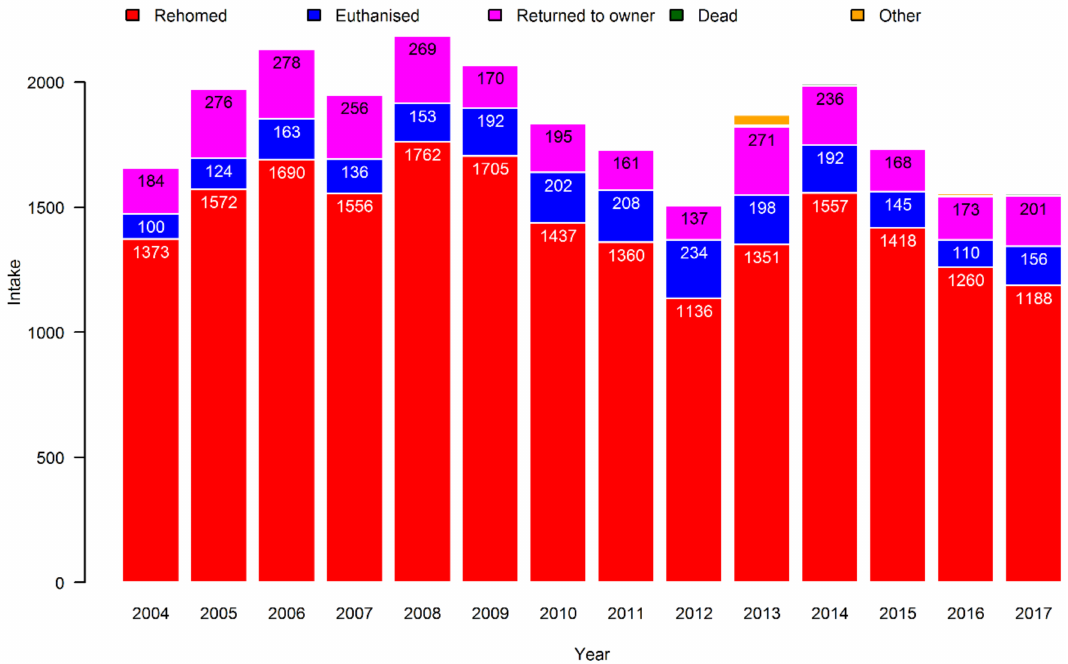
Figure 4. The final outcomes for cats placed in Danish shelters from 2004 to 2017. The categories “Dead” and “Other” contained only 30 and 5 cats, respectively, and are therefore not evident.